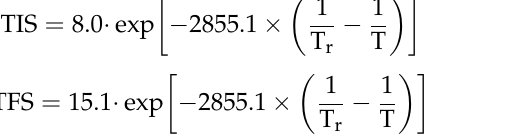
time but without final setting is defined as the warm joint; the layer with the interlayer interval exceeding the final setting time is defined as the cold joint.